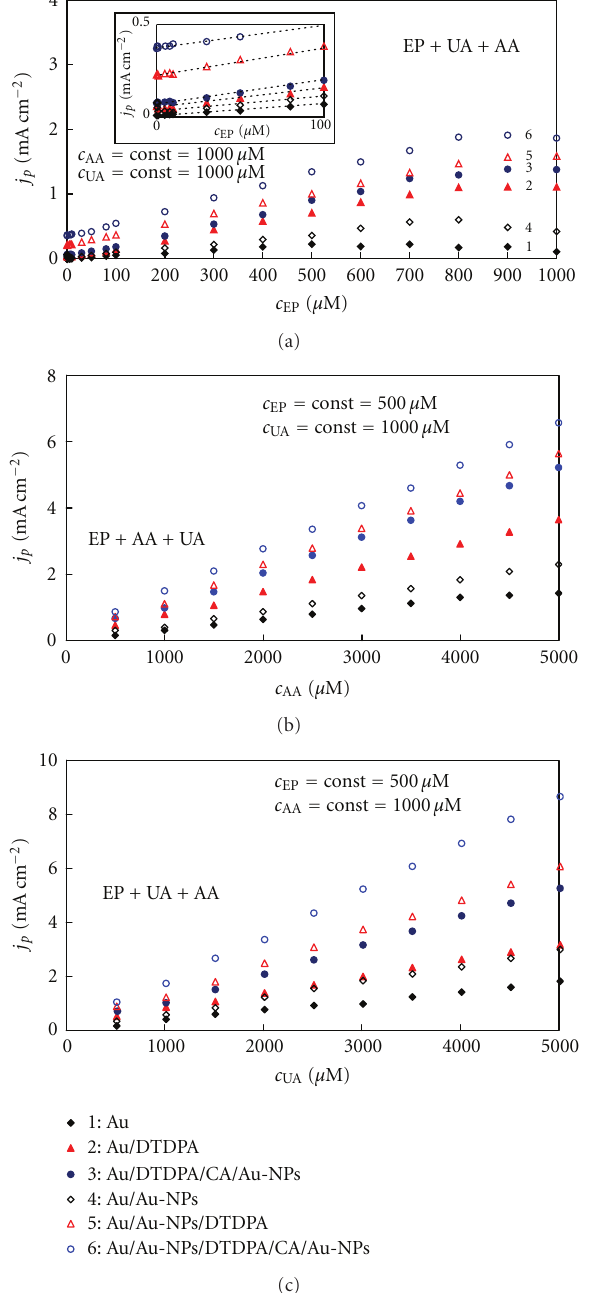
Figure 6: The peak current density versus (a) EP; (b) AA and (c) UA concentration in 60 mM phosphate bu ff er (pH = 7) for modified gold electrodes. v = 0 . 1Vs − 1